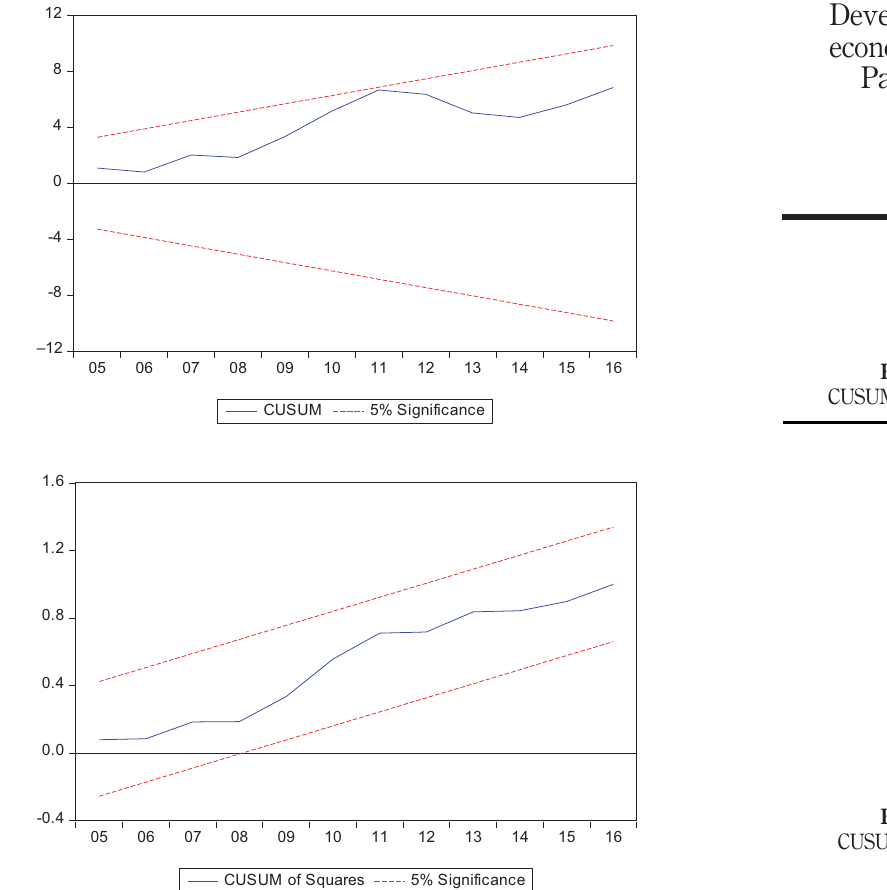
Figure 4. CUSUM Model 2